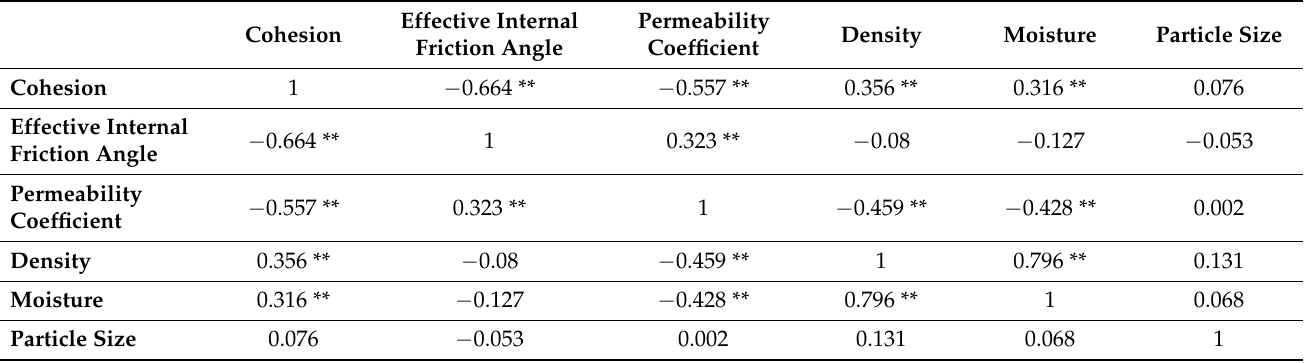
Table 1. Table of correlation coefficients between cohesion and its influencing